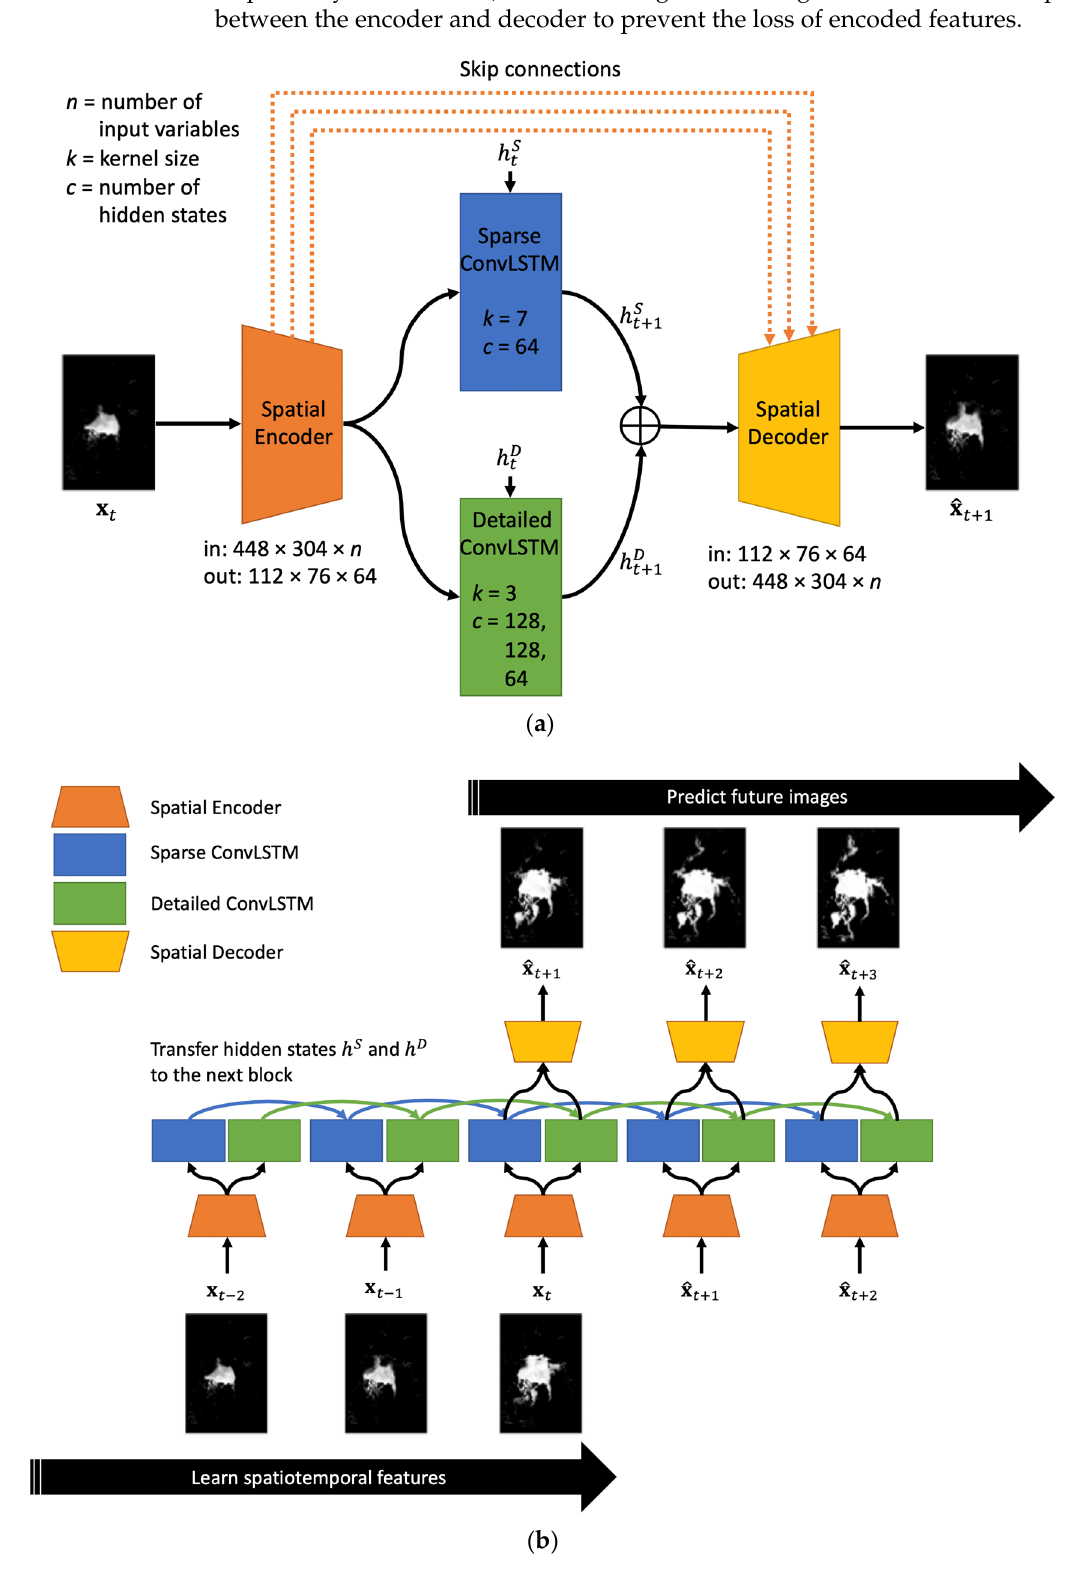
Figure 2. ( a ) A detailed block of the proposed TS-ConvLSTM. There are two streams of the backbone networks to learn different characteristics. ( b ) An overall pipeline of the proposed TS-ConvLSTM for sequence-to-sequence predictions.